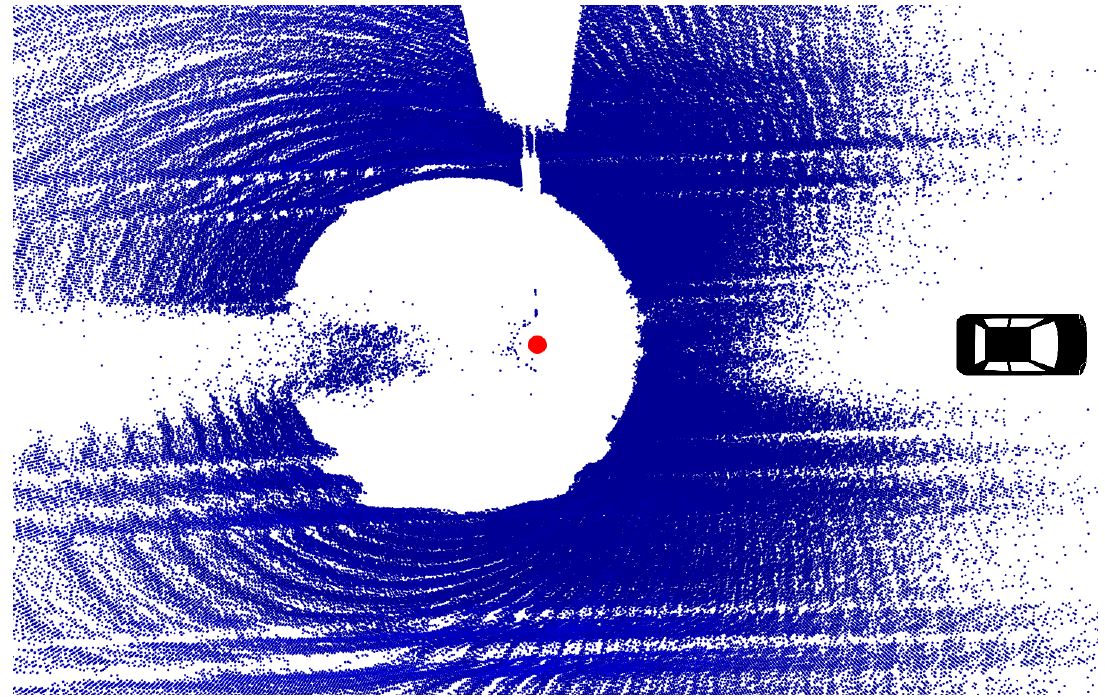
Figure 10. An Ouster point cloud when driving behind a leading vehicle.